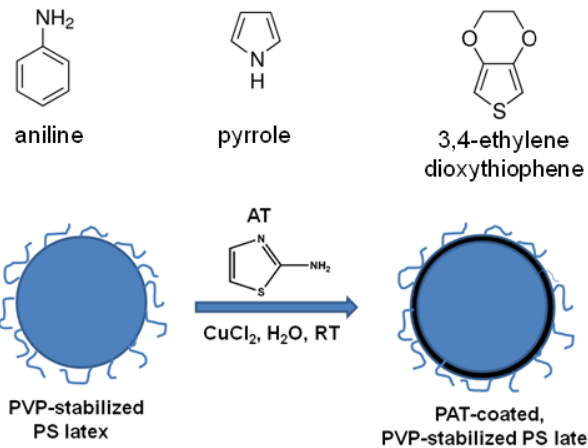
Figure 1. Chemical structures of aniline, pyrrole, 3,4-ethylenedioxythiophene, and 2-aminothiazole, and a scheme for the formation of poly(2-aminothiazole) (PAT)-coated poly( N -vinyl-2-pyrrolidone)-functionalized polystyrene (PS) latex particles.